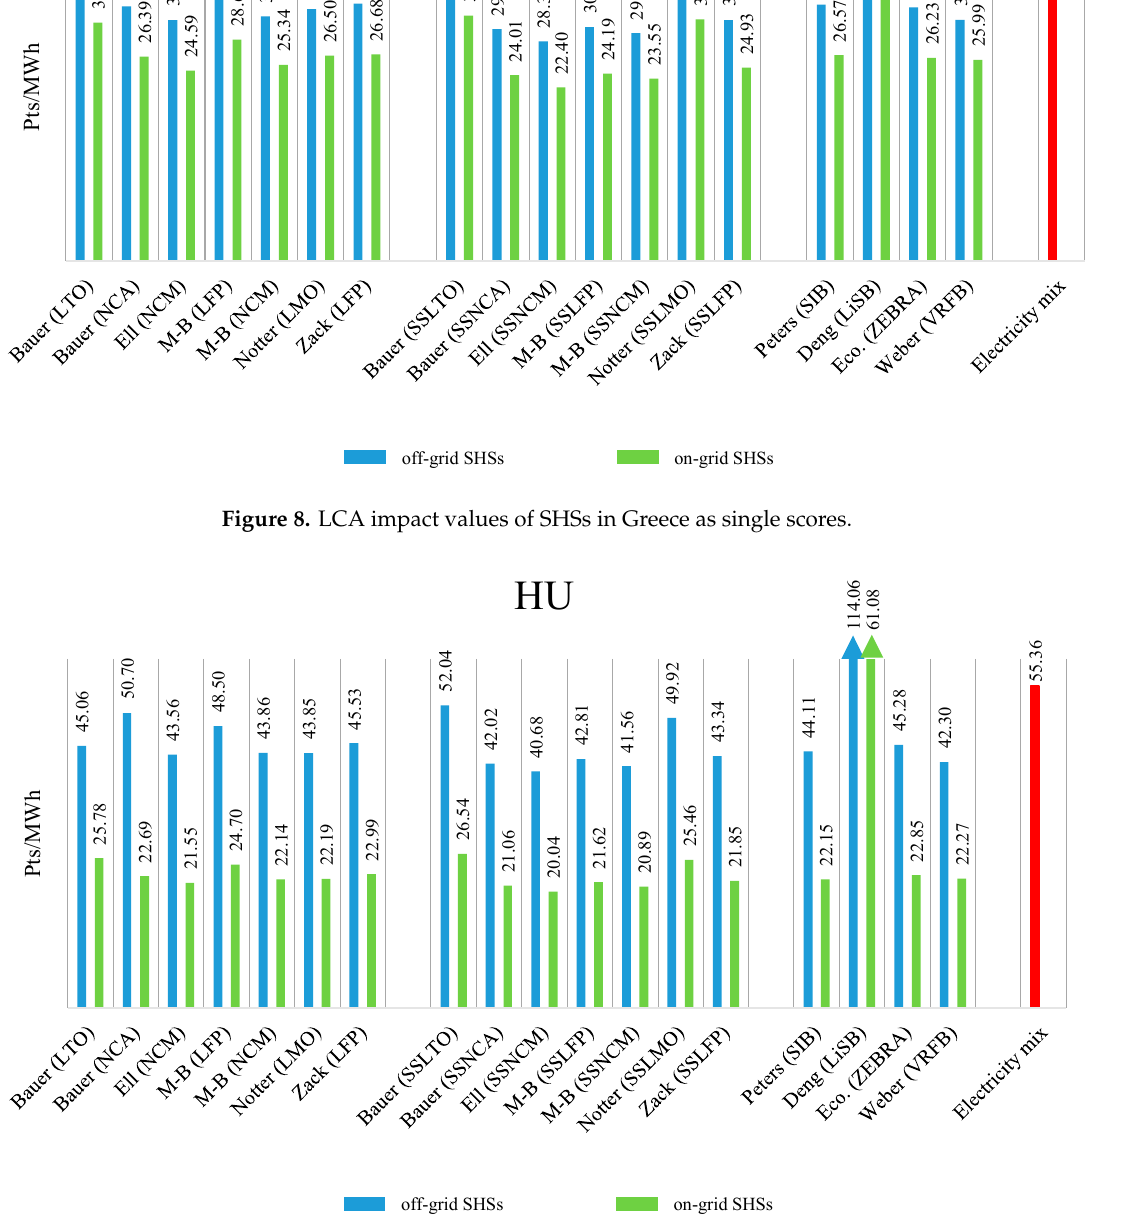
Figure 9. LCA impact values of SHSs in Hungary as single scores.